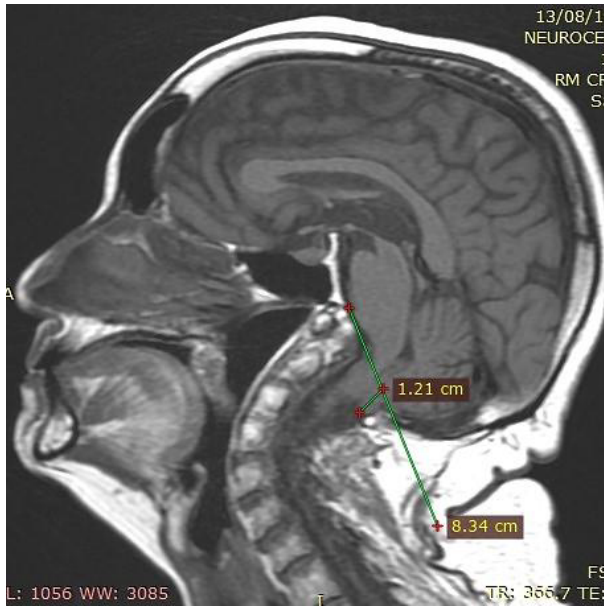
Figure 4 - The cerebellar tonsils migrated 12.1 mm towards the foramen magnum and compressed the bulb posteriorly, consistent with Chiari type I